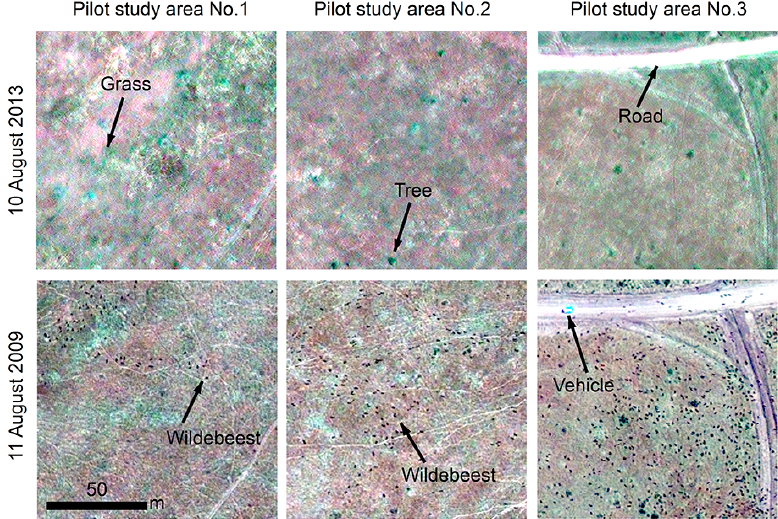
Figure 3. Visual interpretation of target animals by comparing two pan-sharpened GeoEye-1 images (0.5 m): one acquired 10 August 2013, without large animals present (top), and one acquired 11 August 2009, with large animals (bottom). The three pilot study areas represent the complexity of the landscape and the abundance of animals appearing in these images, from left to right: low, moderate and